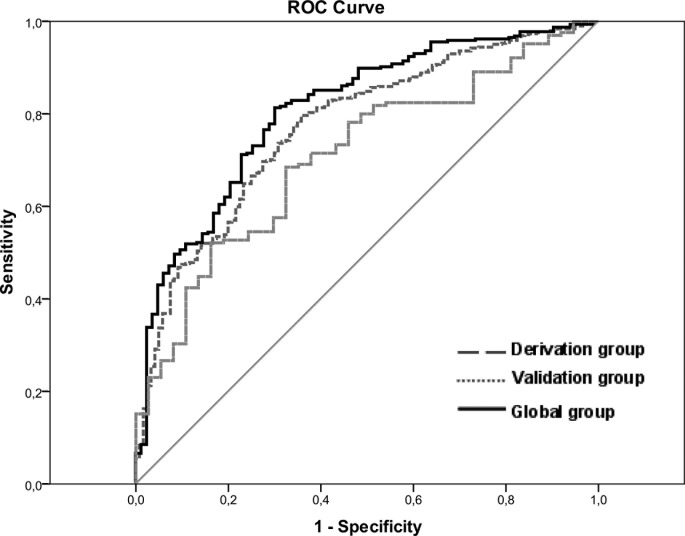
AUROC curve analysis for RD1L, including the overall
cohort (0.79; p<0.001), the estimation cohort (0.77;
p<0.001) and the validation cohort (0.71; p<0.001)